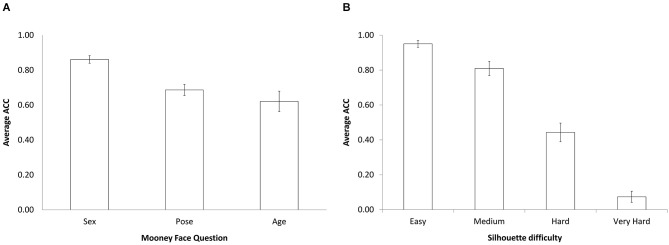
Behavioral analysis of the two visual tasks. (A) Mooney face accuracy analysis—X-axis represents the three questions of the task, Y-axis—mean accuracy rate (including error bars). (B) silhouette accuracy analysis—X-axis represents the four difficulty categories of the task, Y-axis—mean accuracy rate (including error bars).